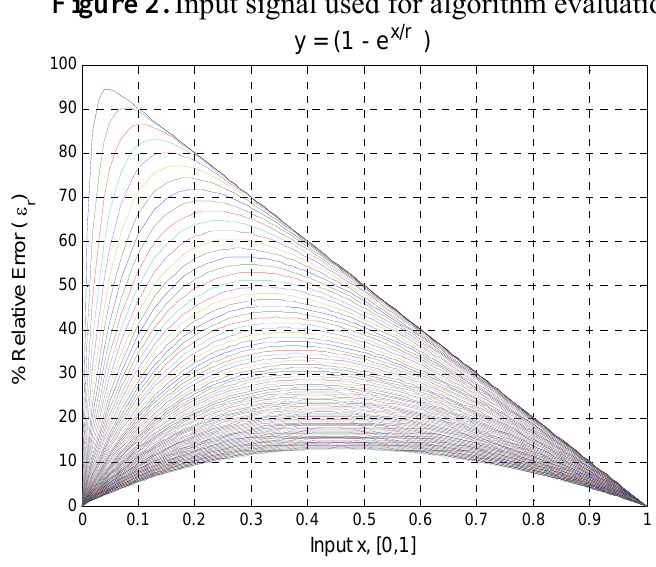
Figure 2. Input signal used for algorithm